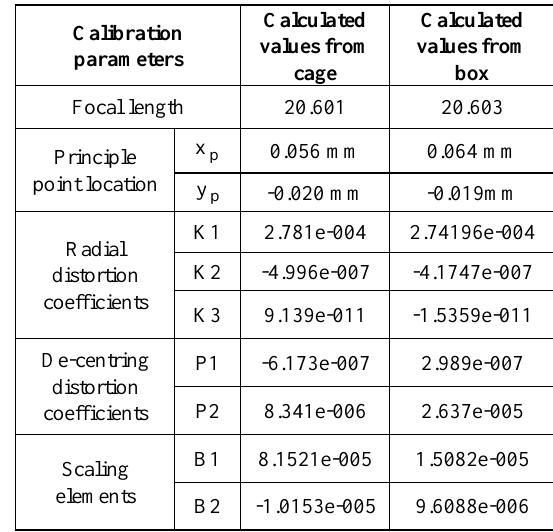
Figure 6. Graphical representation of the bundle adjustment solution for (a) Cage and (b) Box based camera calibration